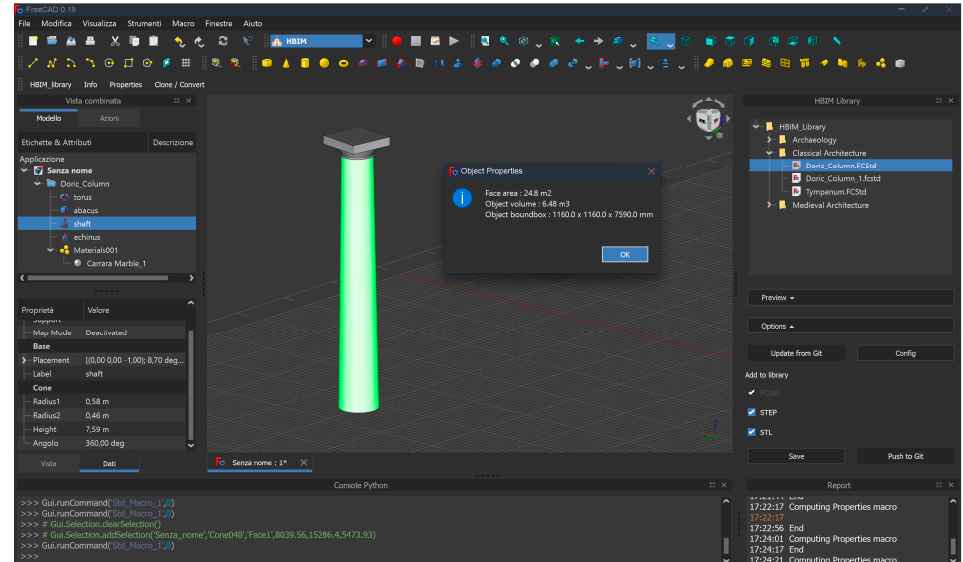
Figure 5. HBIM_Library macro inside FreeCAD for evocating predefined custom parametric models. The column is composed of PART elements such as torus, cubes and cones. The macro is included inside the HBIM workbench.